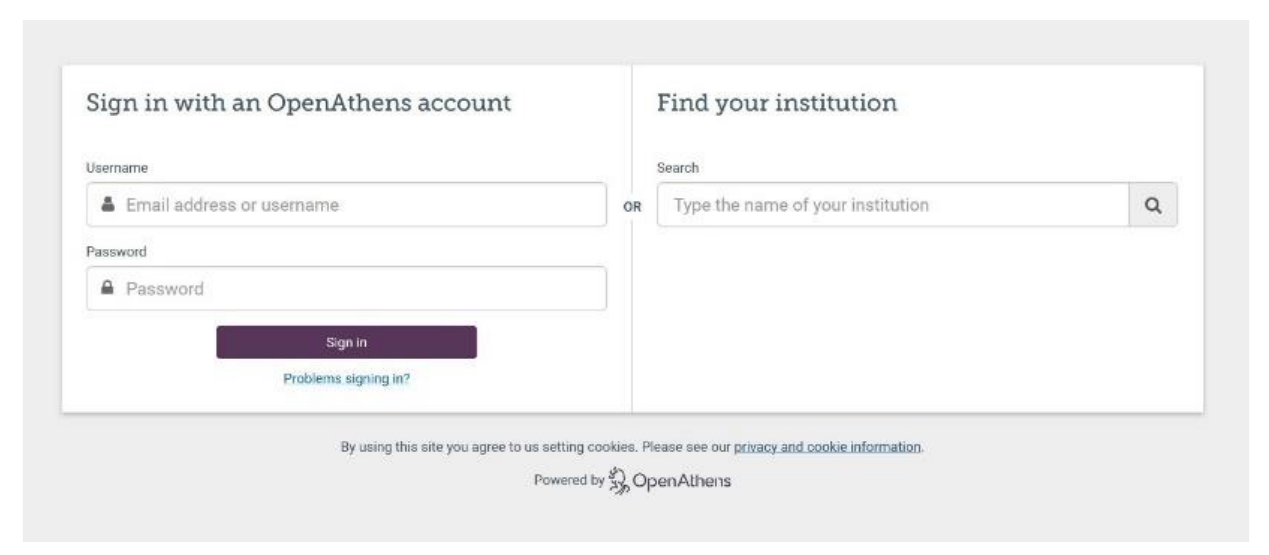
Figure 2 OpenAthens generic log-in